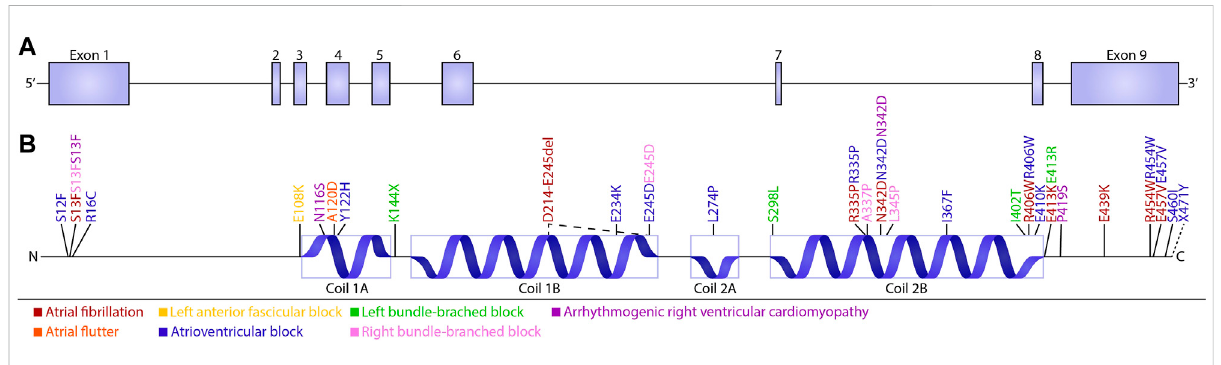
FIGURE 3 Schematic overview of cardiac conduction defects and arrhythmias associated with DES variants. (A) Schematic overview of the DES gene consisting of nine exons. (B) Schematic domain organization of desmin and the localization of the known conduction defects and arrhythmias associated with DES variants. Variants are subdivided into fi ve groups depending on their related phenotype: Atrial fi brillation (brown), Left anterior fascicular block (yellow), Left bundle-branched block (green), Arrhythmogenic right ventricular cardiomyopathy (purple), Atrial fl utter (orange), atrioventricular block (blue), and Right bundle-branched block